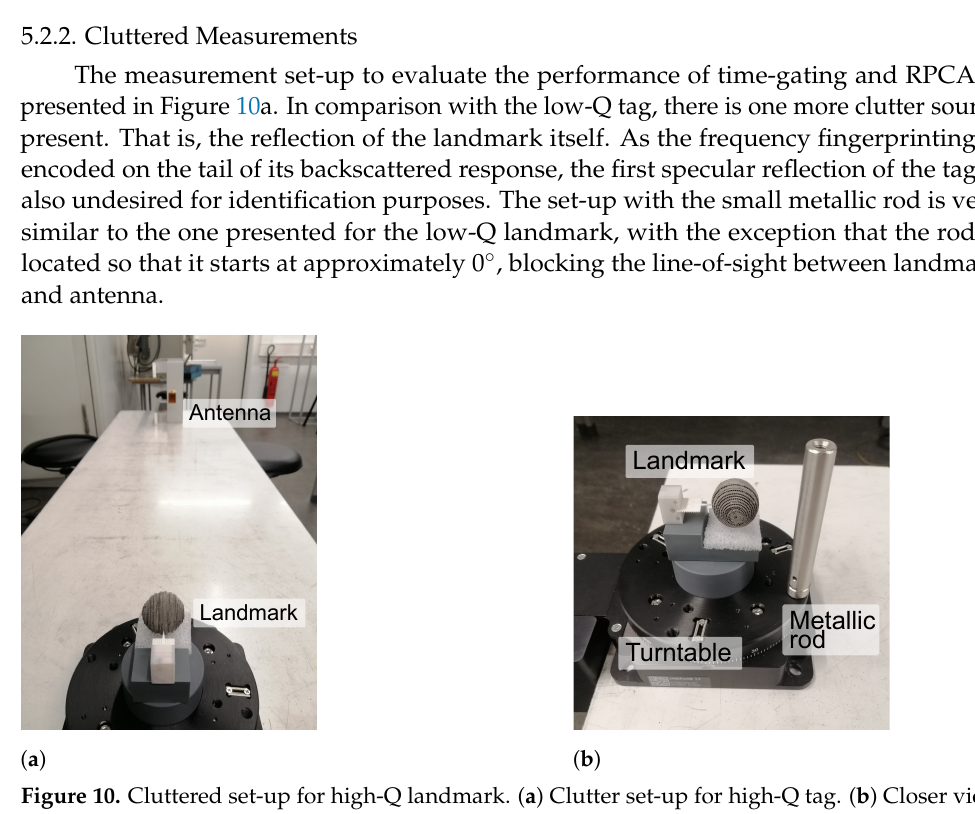
Figure 9. Free-space measurement for high-Q landmark. ( a ) Received time response. ( b ) Backscat- tered frequency response. The raw received signal is not shown.